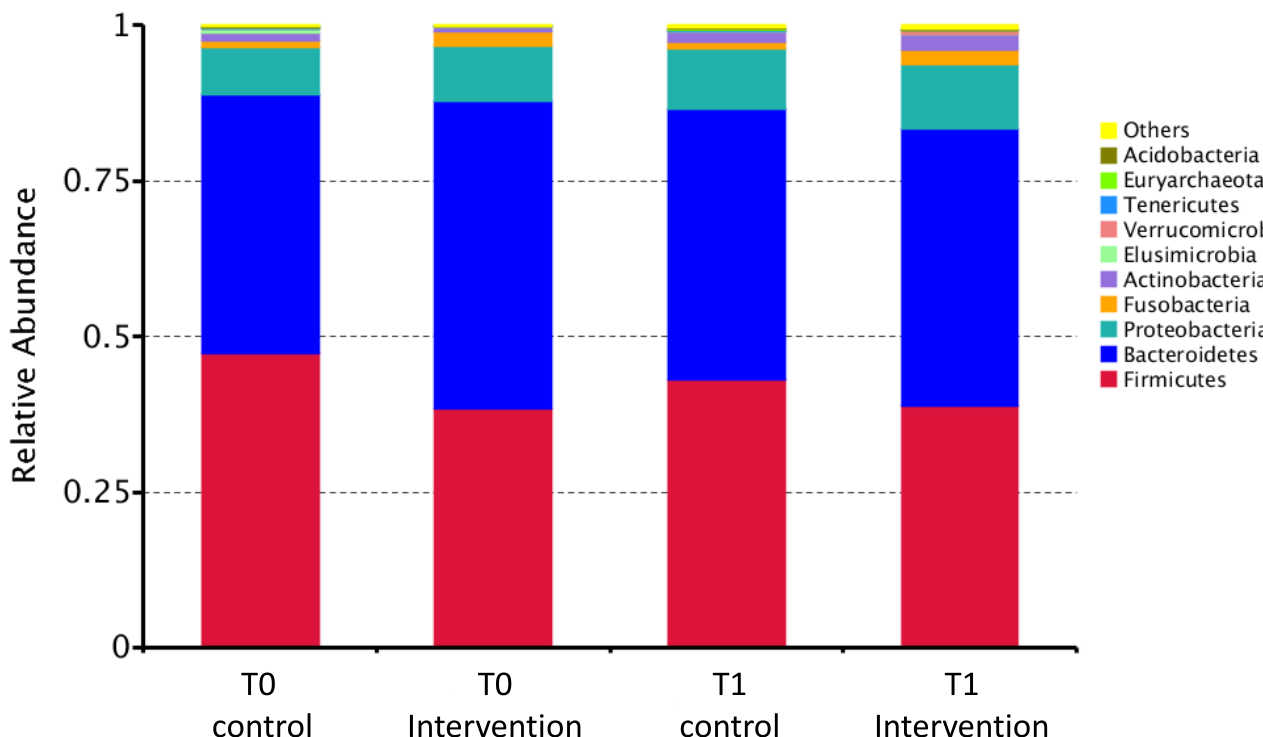
Figure 2. A bar chart showing the relative abundance of the bacteria in the intestinal microbiota at the phylum level among the intervention and control participants at T0 and T1. Table 4. Changes in the absolute abundance values indicating the faecal abundance of bacteria in various taxonomic levels between T0 and T1 among the control and intervention participants.